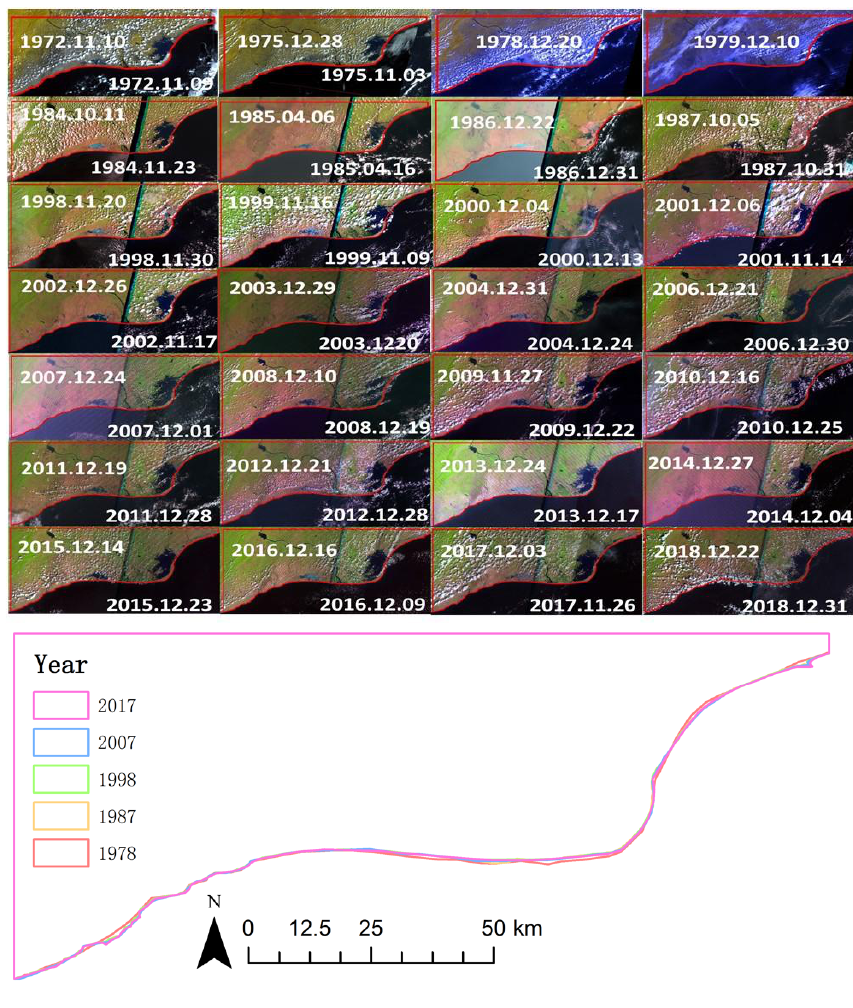
Figure 5. Shorelines extracted from the remote sensing images from 1972 to 2018.